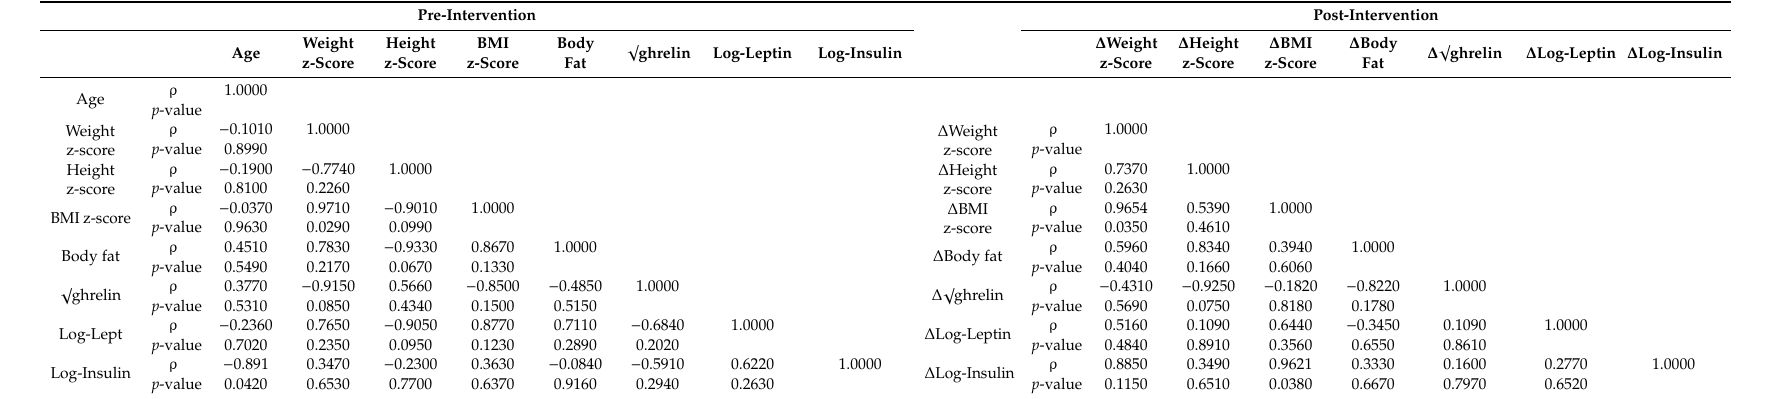
Table 5. Associations between nutritional status, body composition, ghrelin and leptin at the baseline and 12-months in adults. Pre-Intervention